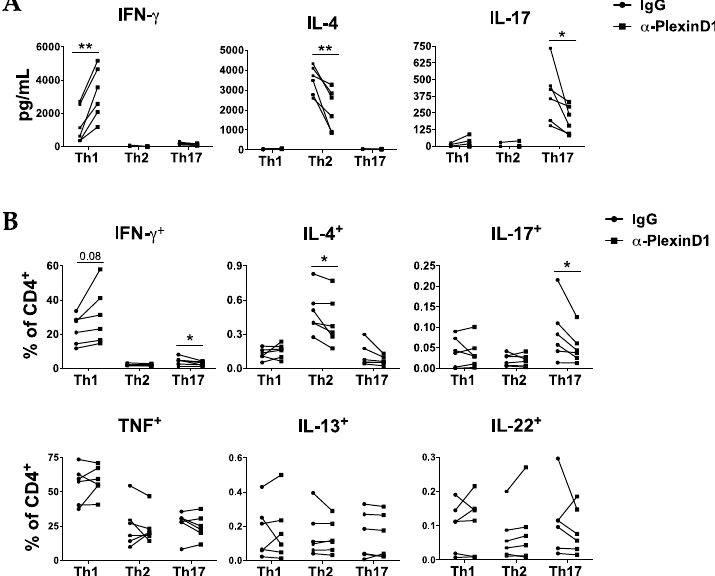
Figure 3. Sema4A-PlexinD1 axis inhibits Th1 and promotes Th2 and Th17 differentiation. Cytokine secretion ( A ) and intracellular cytokine production ( B ) in naïve CD4 + T cells differentiated with Th1,